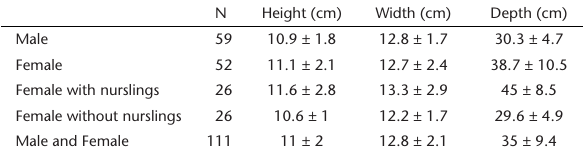
Table 1. Measurements of Tolypeutes matacus burrows at Santa Teresa ranch, Corumbá, Mato Grosso do Sul, and Duas Lagoas ranch, Cáceres, Mato